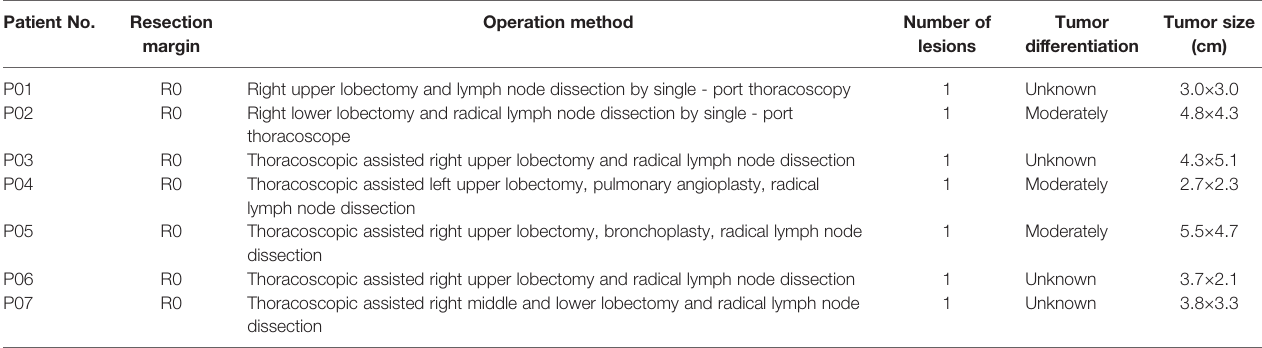
TABLE 2 | Surgical methods and results. Patient No.